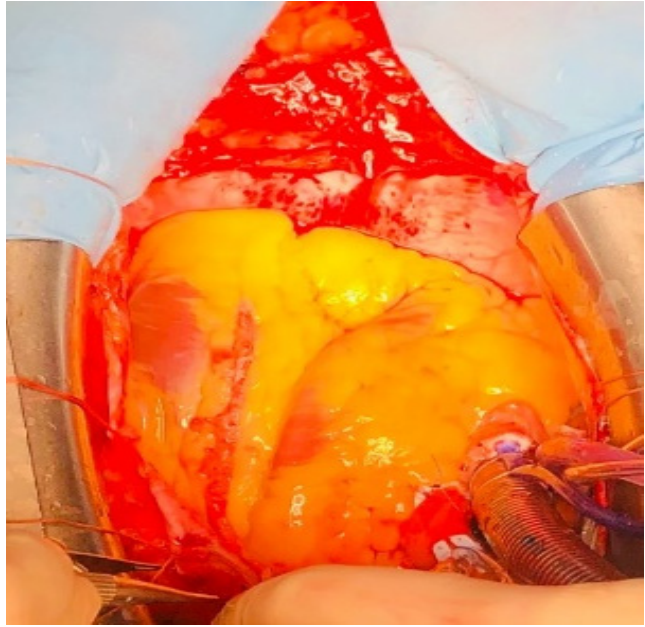
Figure 4. Final result after declamping de left internal mammary